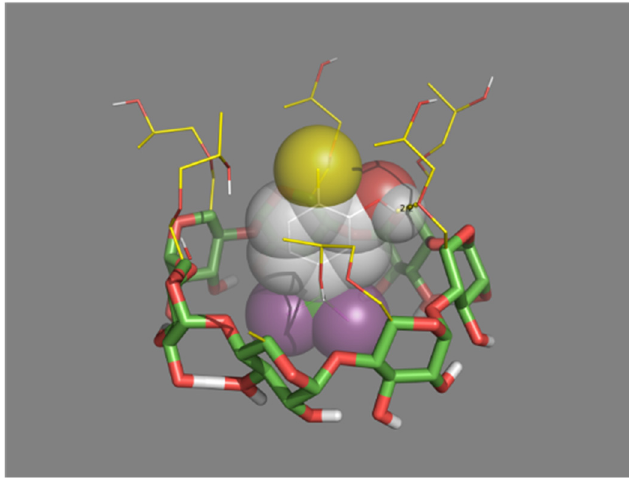
Figure 8. Structure of the carvacrol inclusion complex, with HP- β -CDs.